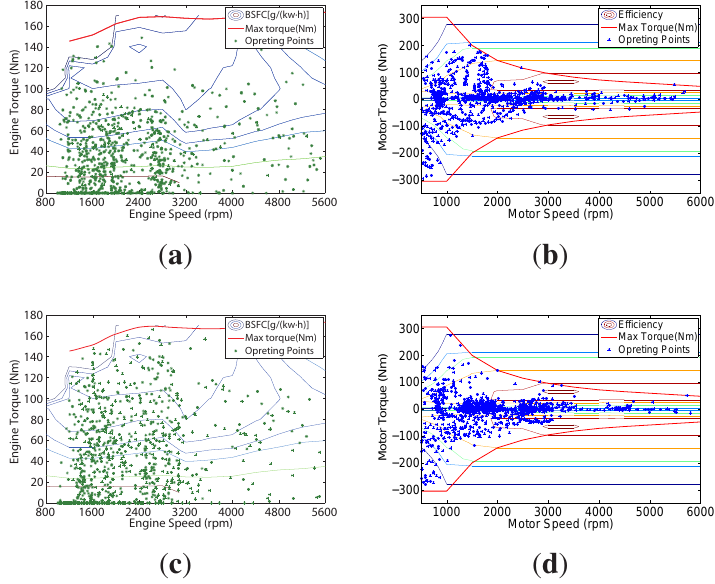
Figure 15. Operating points of the engine and motor in ζ = 0 . 82 and ζ = 0 . 33 . ( a ) Operating points of the engine, ζ = 0 . 82 ; ( b ) operating points of the motor, ζ = 0 . 82 ; ( c ) operating points of the engine, ζ = 0 . 33 ; ( d ) operating points of the motor, ζ = 0 . 33